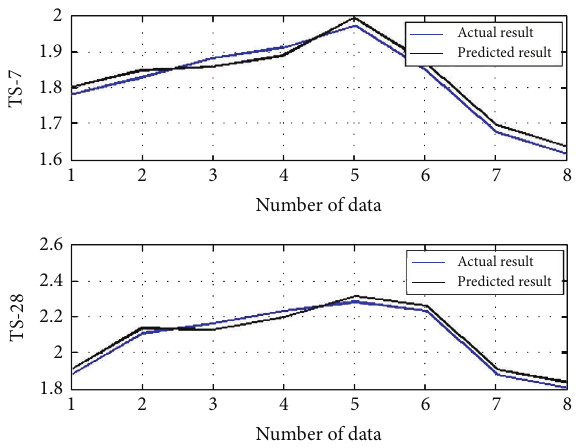
Figure 9: Prediction of split tensile strength.